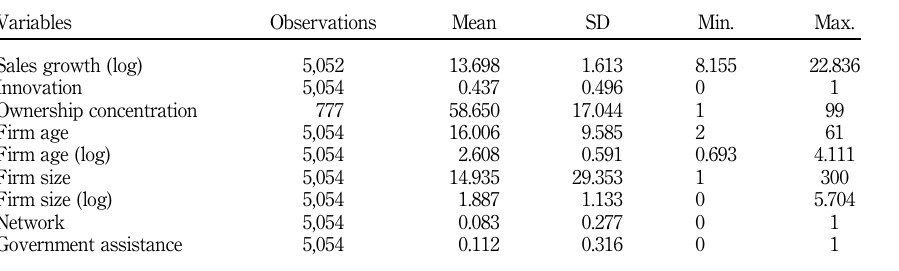
Table I. Summary